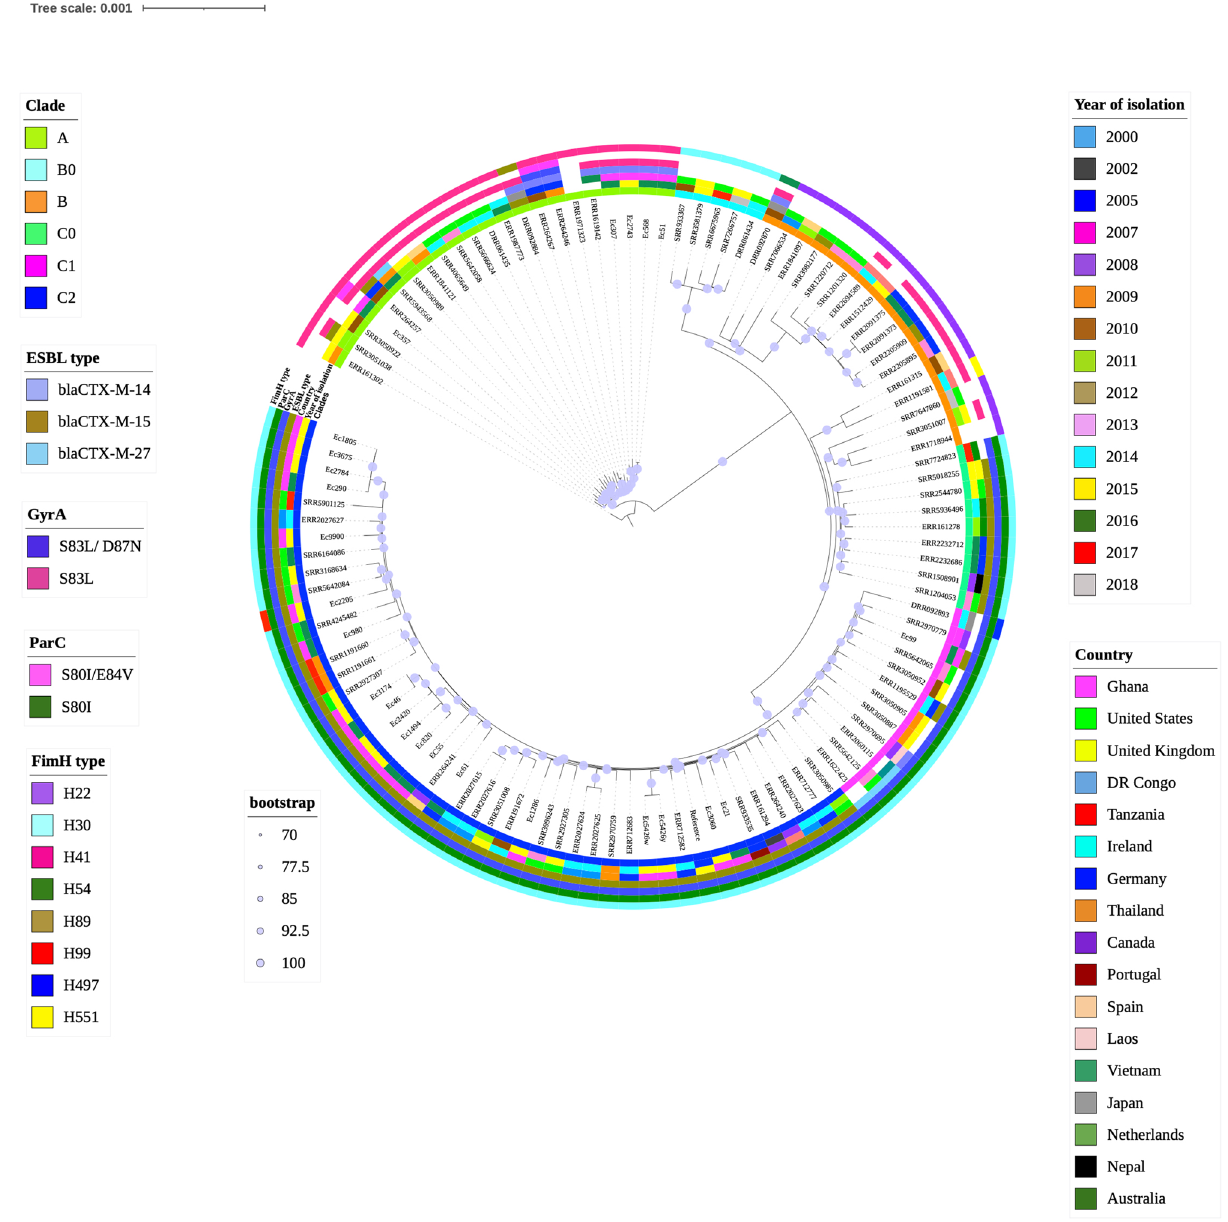
Figure 4. Rooted maximum-likelihood phylogenetic tree of 25 Escherichia coli ST131 and 86 E. coli ST131 representing the global collection. The phylogenetic tree was built based on 2656 core genome SNPs alignment. Branch patterns were assessed by 1000 bootstrap replicates. Bootstrap support values are shown from 70 (minimum) to 100 (maximum). Clades A, B0, B, C0, C1, and C2 are represented by strips colored lemon green, turquoise, orange, light green, pink, and blue, respectively. The year and country of isolation are displayed in assorted colored strips. Allelic profiling data are shown as color strips from inside out as the ESBL type, GyrA, ParC, and fim type. Accession numbers and IDs of the strains are labeled at the tips. Figure was visualized and annotated with ITOL v5 (https:// itol. embl. de/ perso nal_ page.